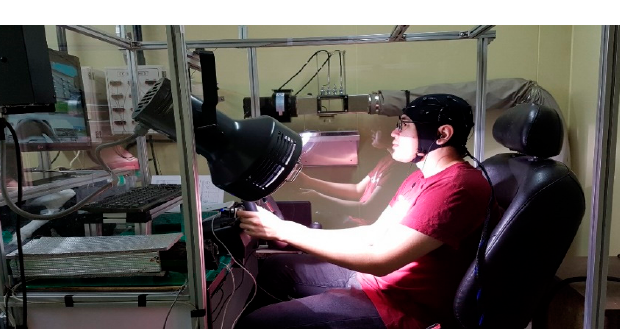
Figure 5. Photograph showing actual experimental state. Table 9. Setting temperature for cooling mode. Table 10. Subjective